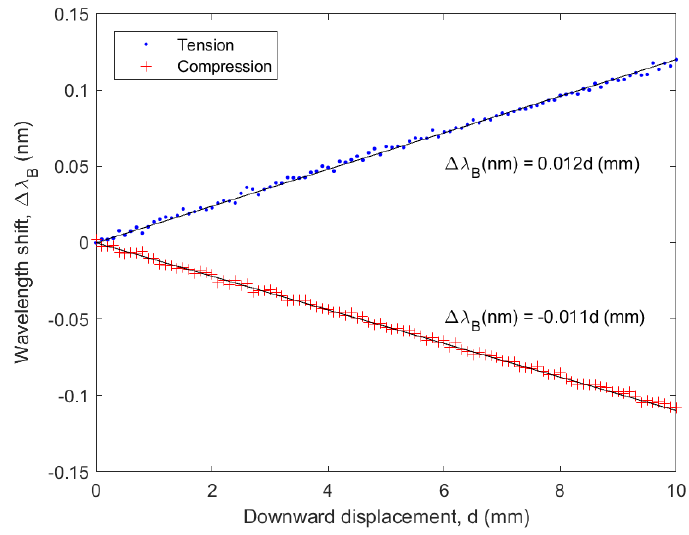
Figure 10. Bragg wavelength shift recorded for sensor 3, in tension and in compression during the cantilever loading